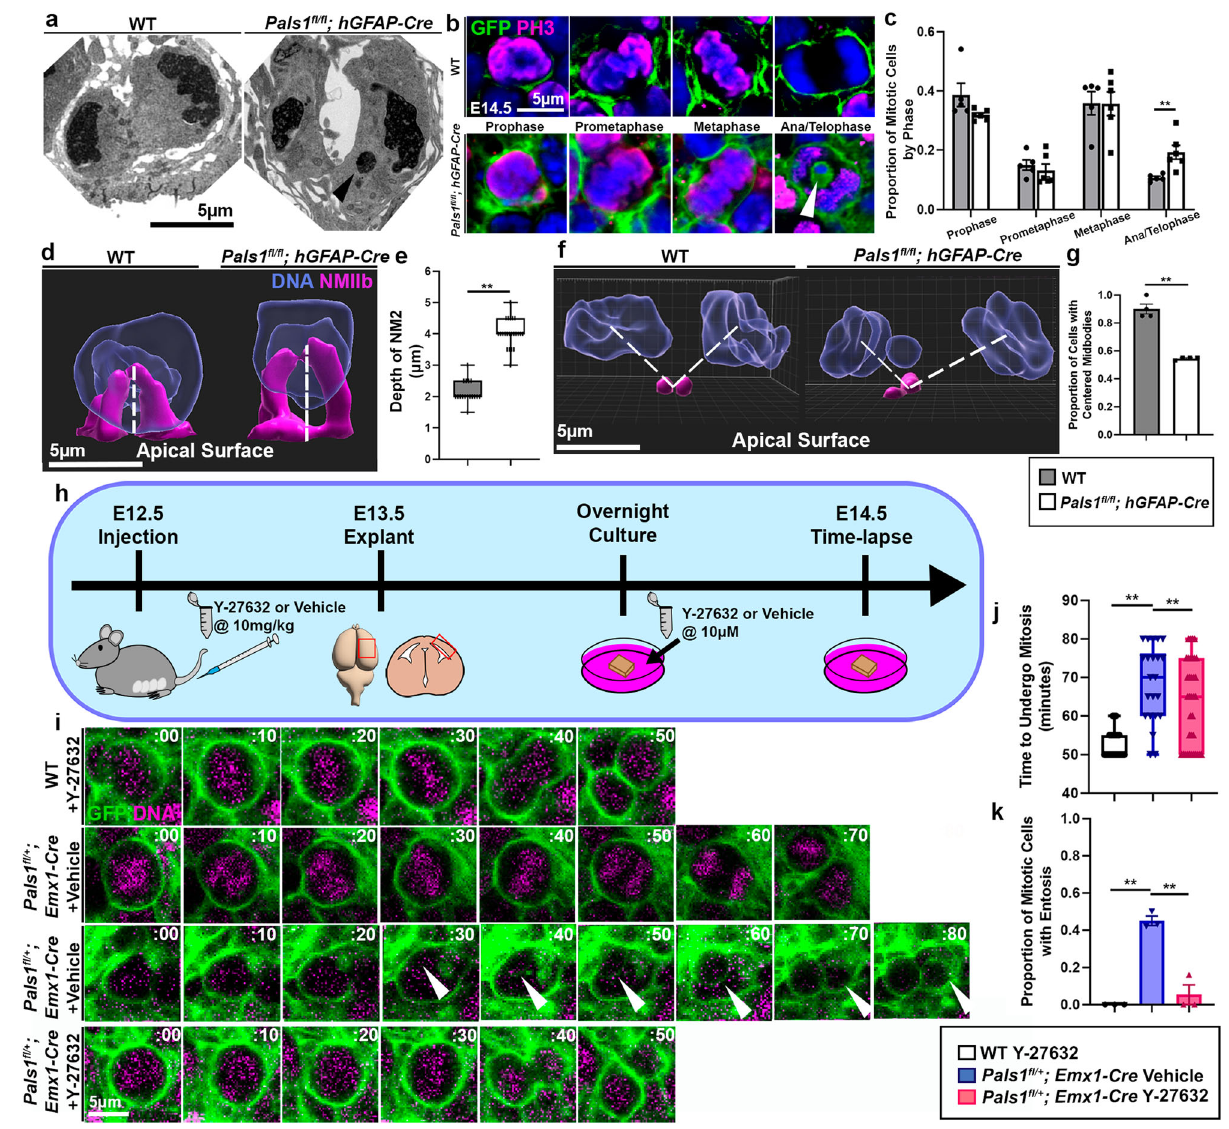
Fig. 2 | CIC structures resulting from abnormal Rho-ROCK activity delay cytokinesis in PALS1-de fi cient neural progenitors. a Transmission electron micrographs reveal the presence of micronuclei in Pals1 fl / fl ; hGFAP-Cre progenitors as indicated by black arrow. Brains from two animals per group were examined in TEM imaging. b , c Mitotic apical progenitors visualized by apical explant staining for membrane GFP and PH3 to amplify membrane-bound GFP. White arrow indi- catesaCICstructurewithinaPALS1-de fi cientprogenitorinana/telophasethatdoes notexpressPH3.Quanti fi cationofapicalprogenitorsbymitoticphaseatE14.5(WT n =5 brains, Pals1 fl / fl ; hGFAP-Cre n =6 brains, 50 cells per brain, Prophase P =0.09, Prometaphase P =0.53, Metaphase P =0.97, Ana/Telophase P =0.01). d , e IMARIS 3D models of cells from apical explants immunostained for NMIIB and quanti fi ca- tion of cleavage furrow height at E14.5. Dotted white lines indicate manner of cleavage furrow height measurements. (WT n =3 brains, Pals1 fl / fl ; hGFAP-Cre n =3 brains, 5 cells per brain P =<.0001). f , g IMARIS 3D models of cells from apical explantsimmunostainedforSURVIVINandquanti fi cationoftheproportionofcells